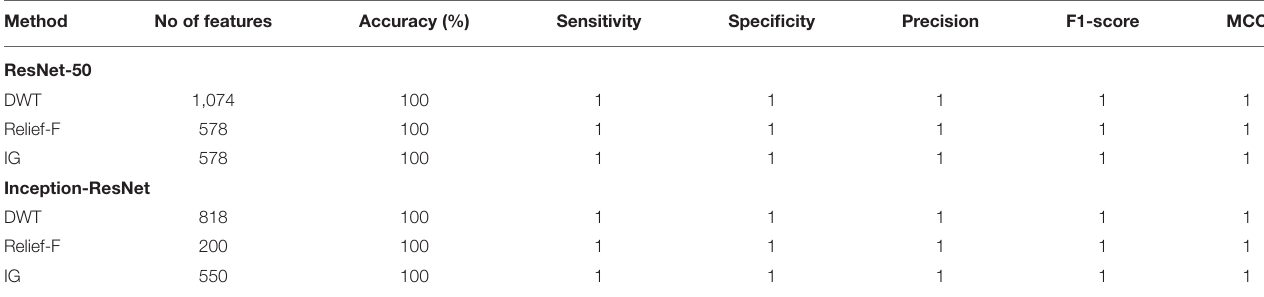
TABLE 5 | Binary classification accuracy (%), number of features, and other performance metrics before and after feature selection for ResNet-50 and Inception-ResNet CNNs. Method No of